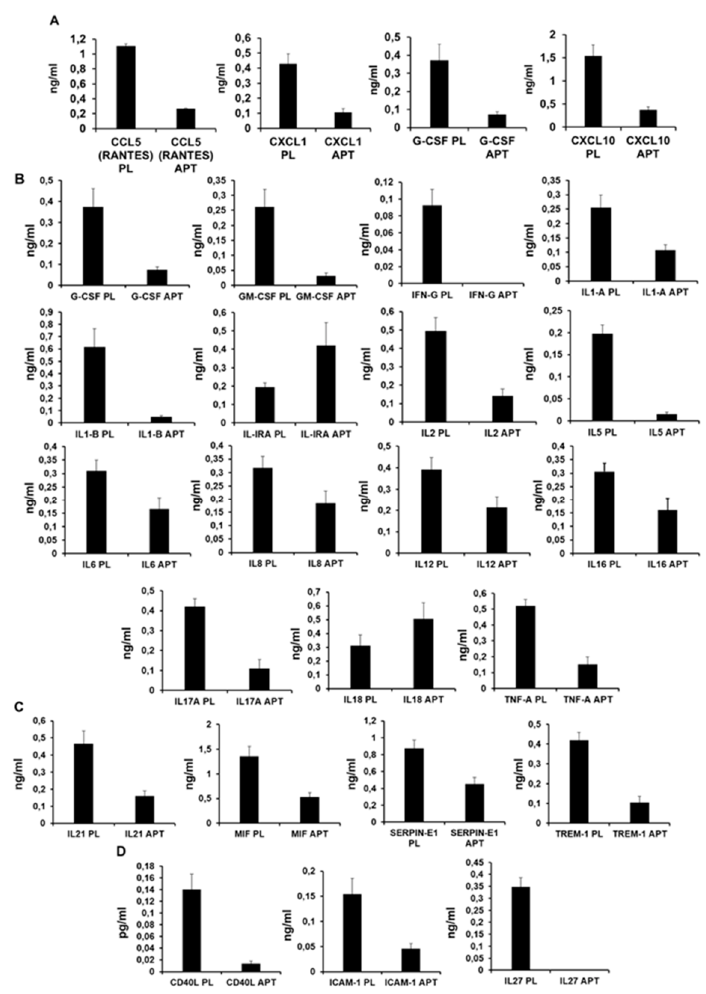
Figure 5. Plasma levels of selected cytokines detected by day 7 after IR. ( A ) Chemokines; ( B ) pro-inflammatory cytokines; ( C ) resolving cytokines; ( D ) miscellaneous. All cytokines depicted presented statistically significant differences between ApTOLL vs. PLACEBO, with p values < 0.001. (N = 9 ApTOLL/8 PLACEBO. Mean ± SD).